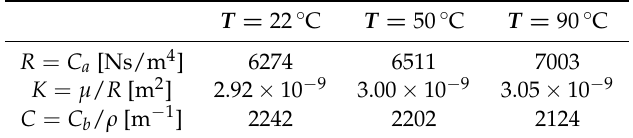
Table 2. Characterizing permeable (P800) material coefficients as a function of fluid